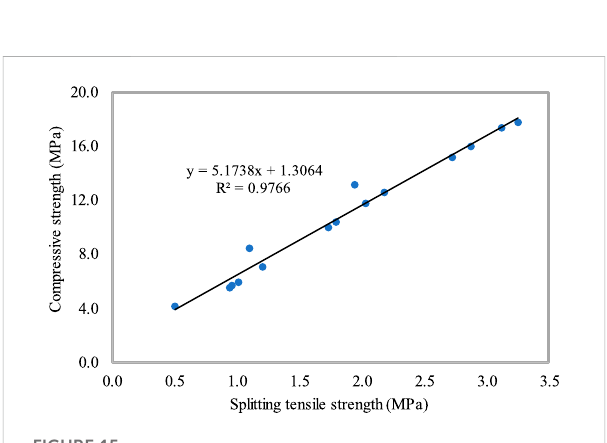
FIGURE 15 Correlation between compressive and tensile strengths of